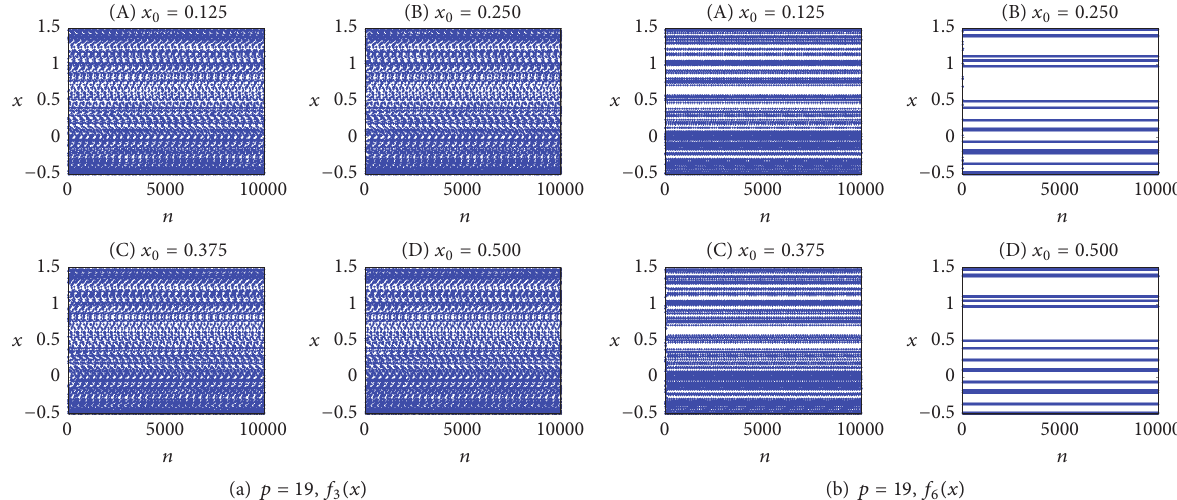
Figure 13: Time series of mostly positive finite precision logistic map at 𝜆 = −1.984375 for different combinations of its parameters.